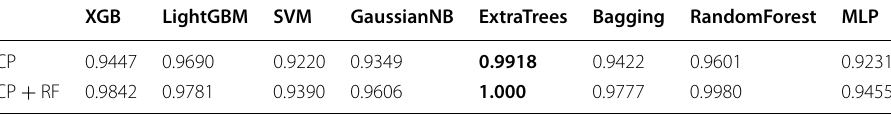
− CP checkpoints; RF risk flag − Checkpoints before MT from D3 dataset are used as model